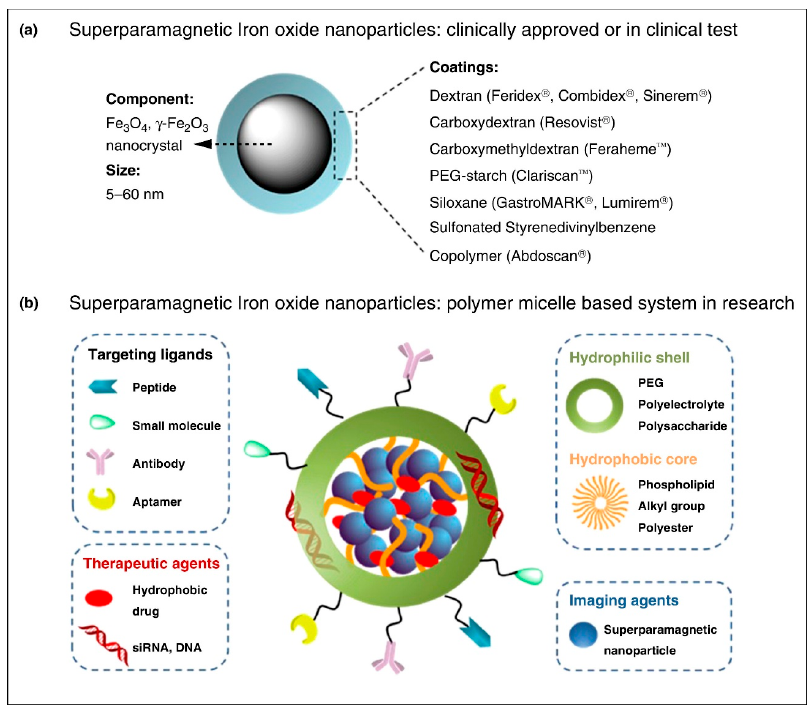
Figure 4. Schematic illustration of the polymer micelle composite system of surface-engineered superparamagnetic iron oxide nanoparticles (SPION) for imaging and therapy application. ( a ) Clinically approved or in clinical test SPION with biocompatible coatings and iron oxide cores; for each kind of coating material, commercial products are listed aside. ( b ) Amphiphilic polymers to form a micelle structure with hydrophilic shell and hydrophobic core. INOPs and hydrophobic drugs are packed into the core, targeting ligands can be coupled onto the hydrophilic surface. Reproduced from “Superparamagnetic iron oxide nanoparticles for MR imaging and therapy: design considerations and clinical applications”, with permission from Elsevier, 2014.